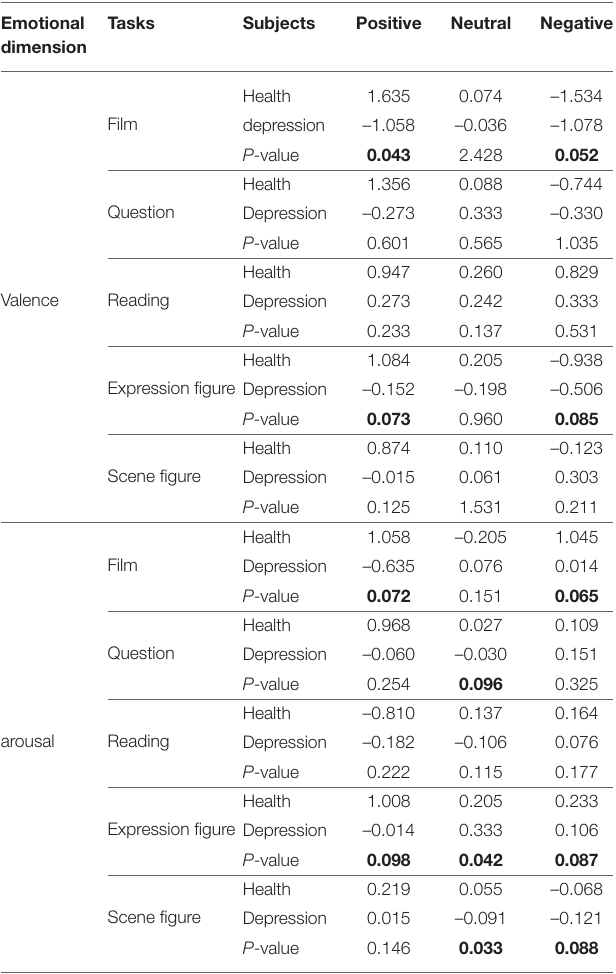
TABLE 2 | The differences in valence and arouse dimension between the healthy and depressed group for the five stimuli with three emotional valences ( P < 0.1). Emotional dimension